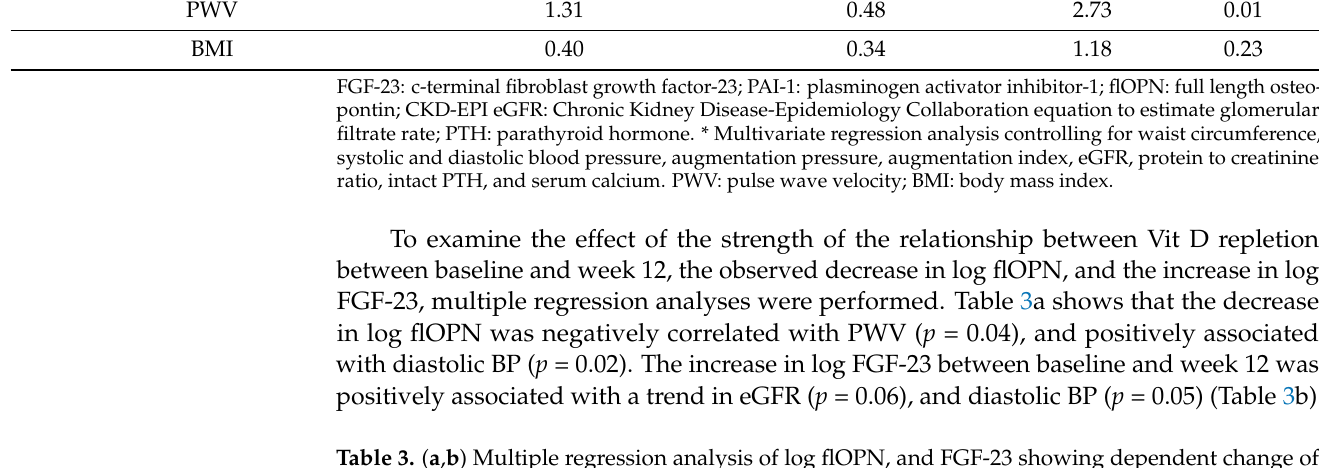
Table 3. ( a , b ) Multiple regression analysis of log flOPN, and FGF-23 showing dependent change of log-biomarker from baseline to week 12 and independent